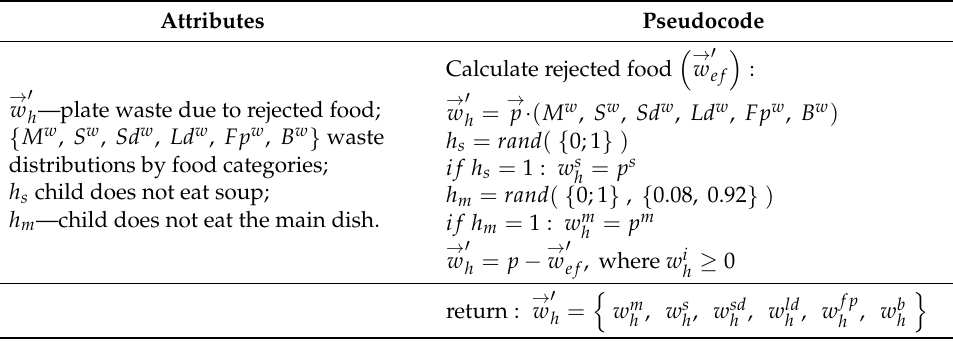
Table 9. Pseudocode for rejected food impact